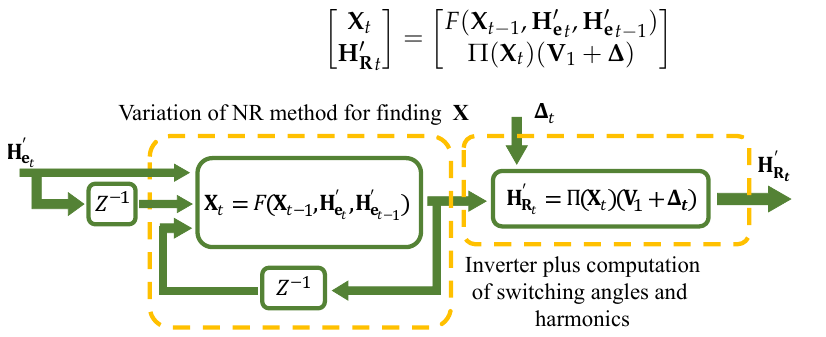
Figure 7. virtual dynamic model of the